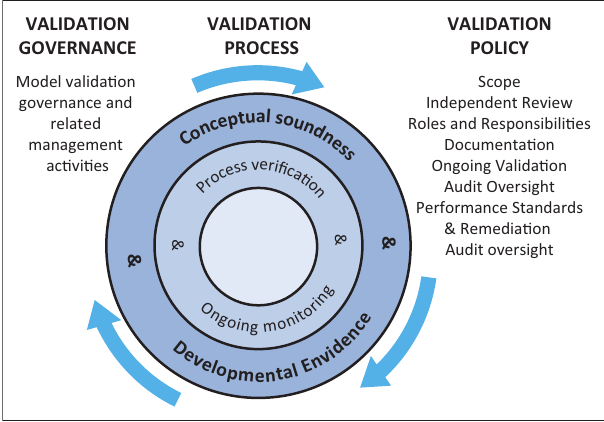
FIGURE 2: Representation of the proposed